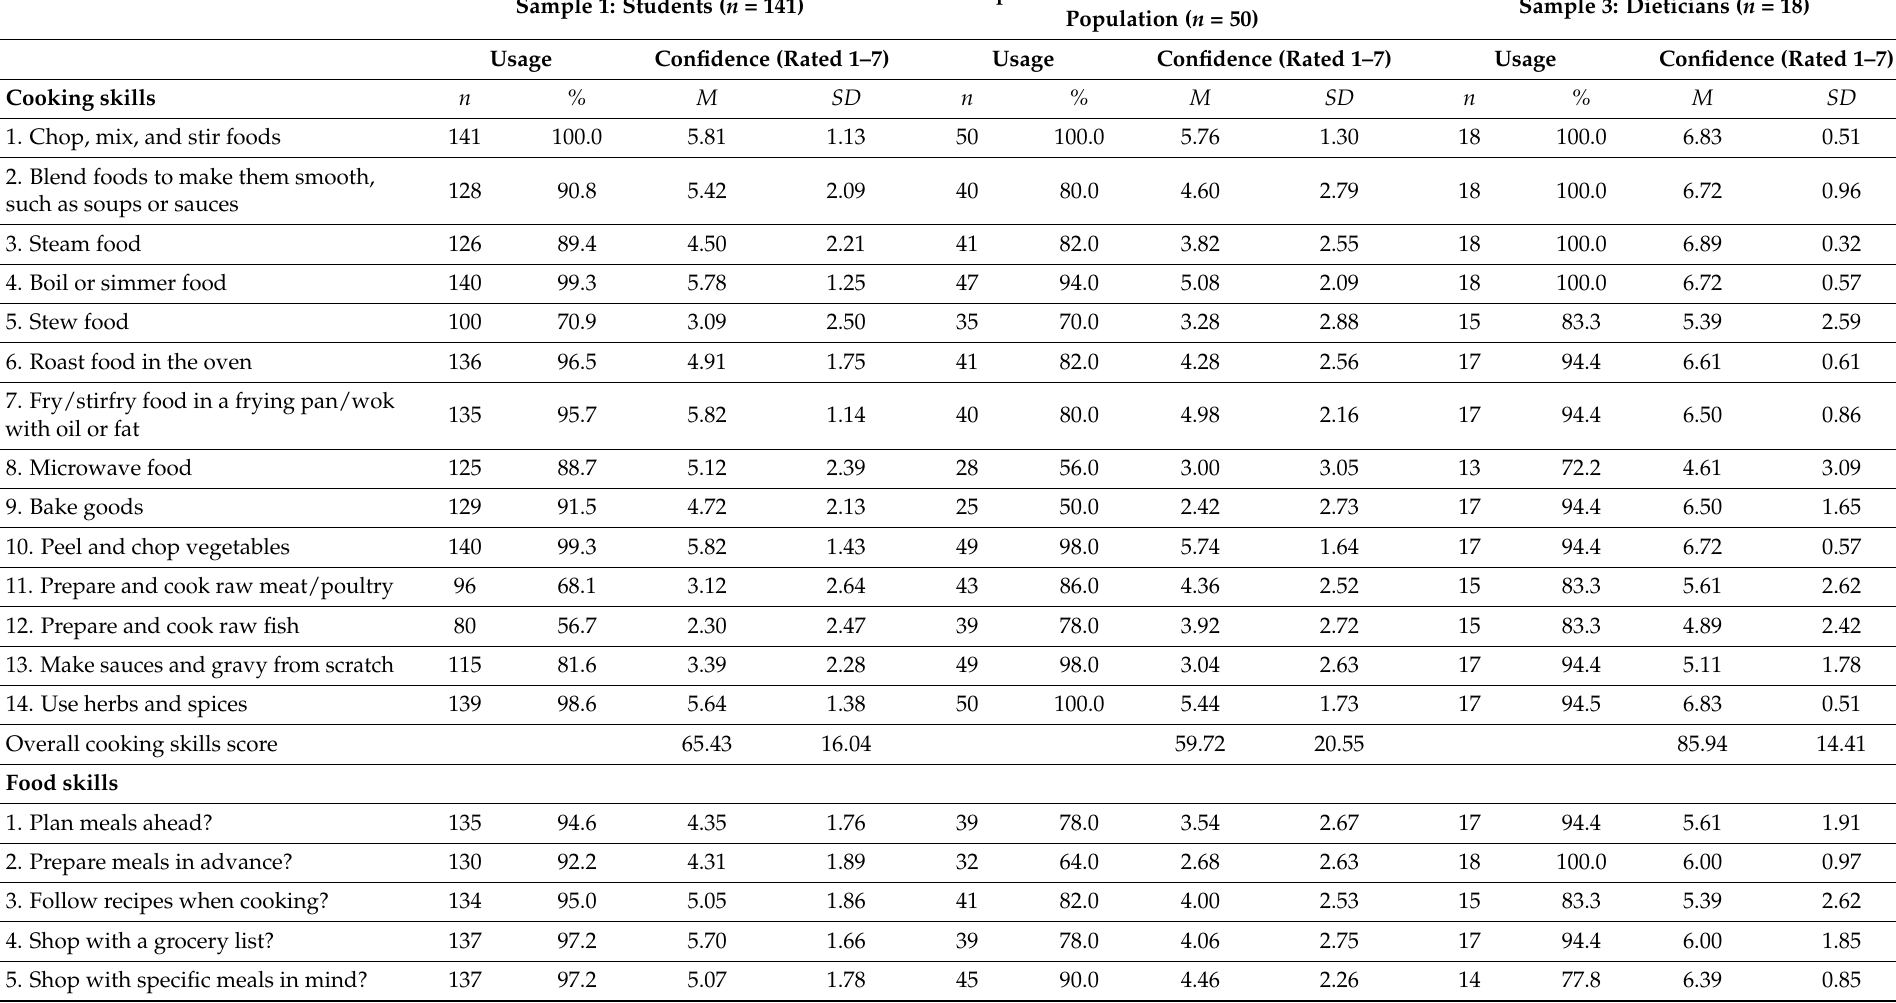
Table 1. Usage and confidence in cooking skills and food